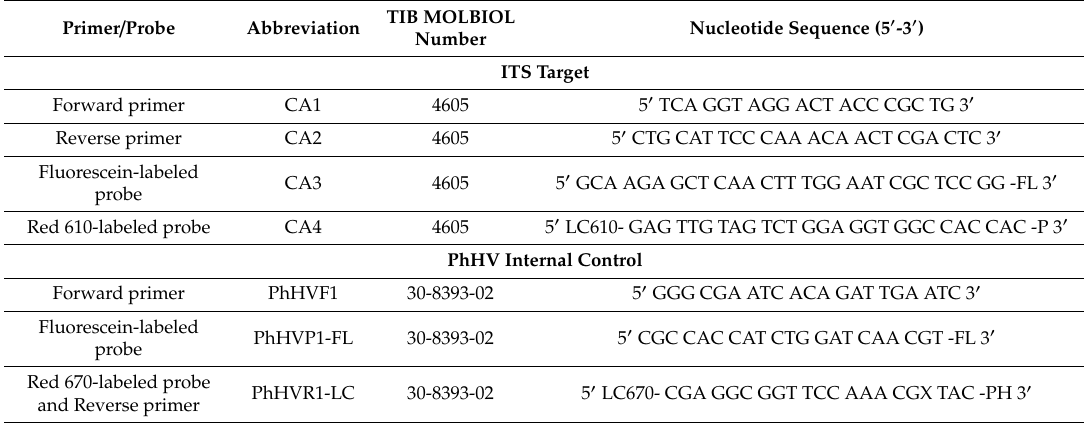
Table 1. Candida auris PCR assay primer and probe